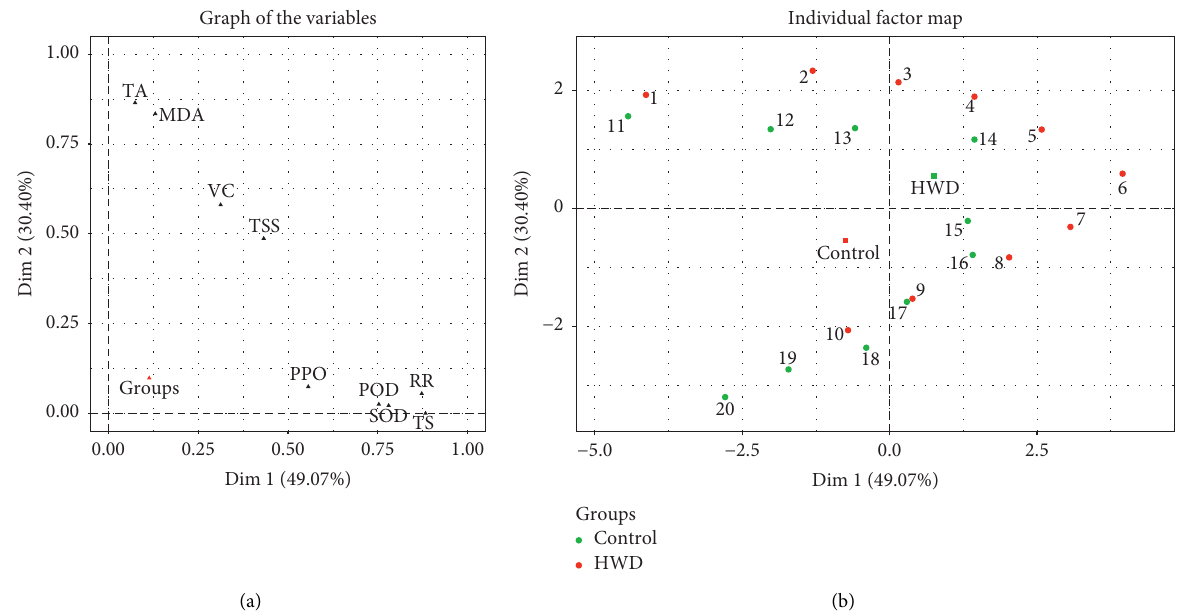
Figure 5: Two-dimensional principal component analysis (PC1: 49.07% and PC2: 30.40%) of the biochemical quality parameters during storage. (a) Graph of the variables and (b) individual factor map (TA: titratable acidity; MDA: malondialdehyde content; VC: vitamin C; TSS: total soluble solids; PPO: polyphenoloxidase; POD: peroxidase; SOD: superoxide dismutase; RR: respiration rate; TS: total